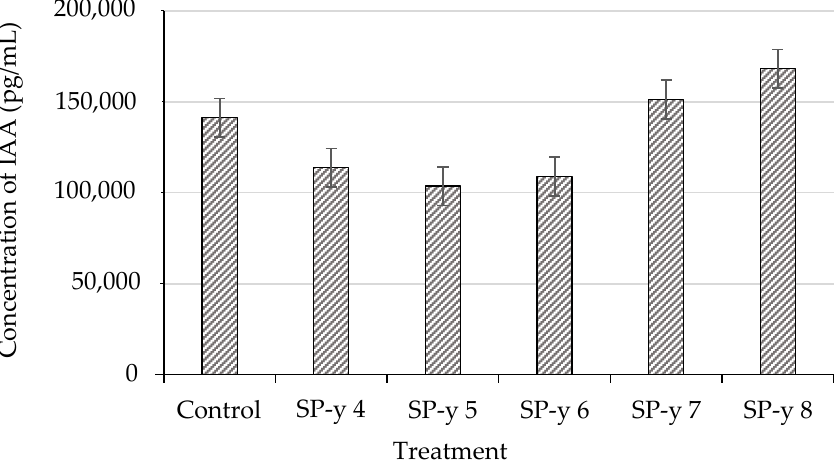
Figure 7. Indole-3-acetic acid (IAA) concentrations produced by rice seedlings inoculated with S. yanoikuyae SJTF8 at different CFU/mL levels.